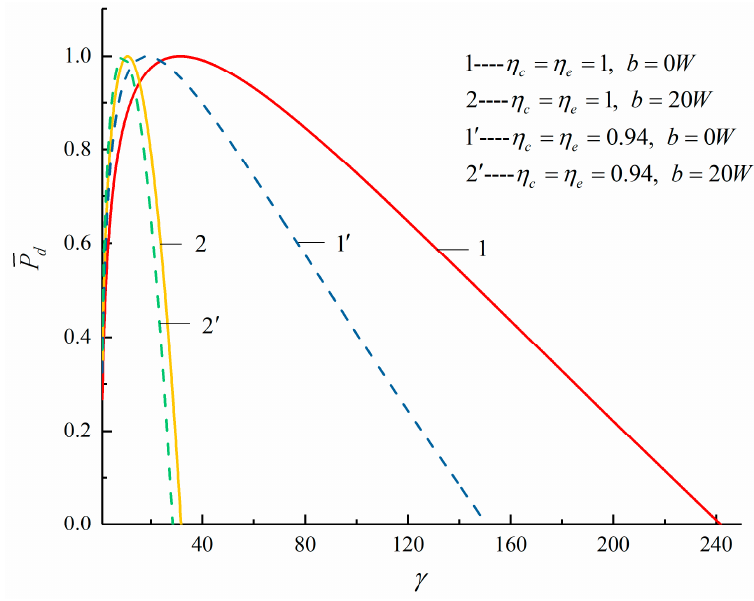
Figure 4. The curves of P d − γ about η c , η e , and b .